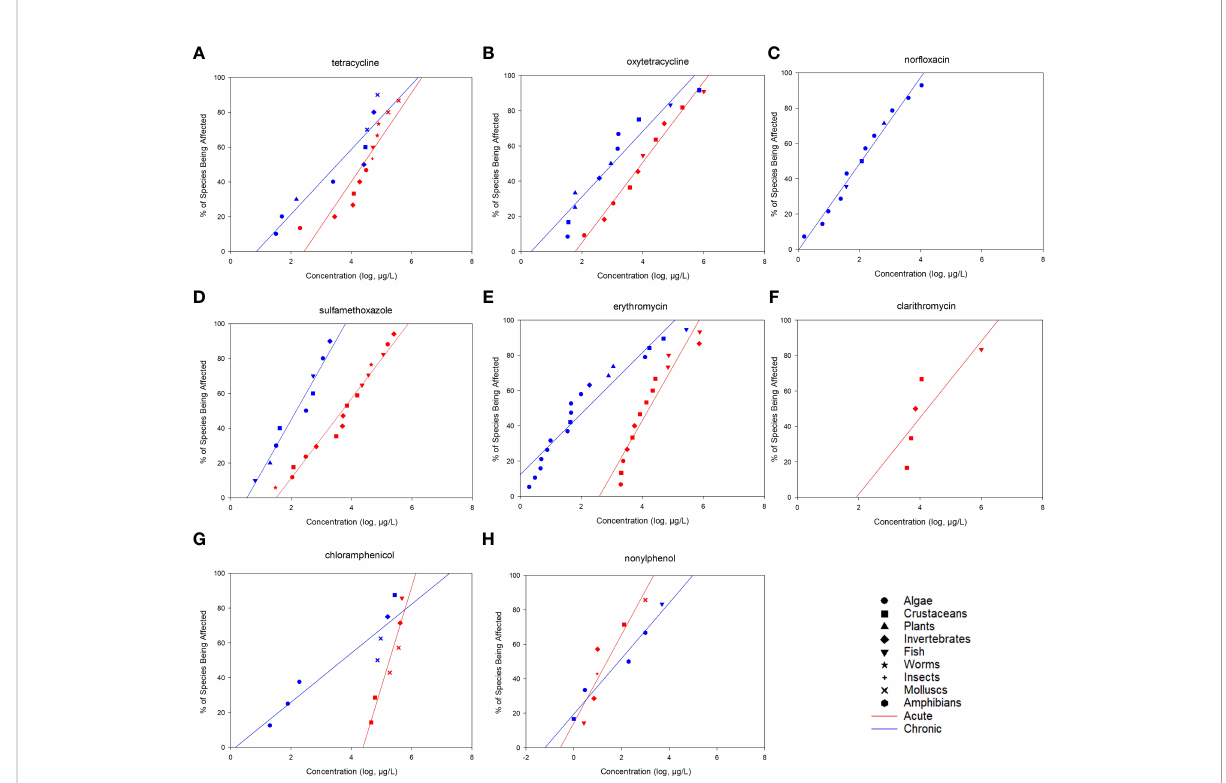
FIGURE 1 Freshwater acute (red) and chronic (blue) species sensitivity distributions (SSDs) for (A) tetracycline, (B) oxytetracycline, (C) nor fl oxacin, (D) sulfamethoxazole, (E) erythromycin, (F) clarithromycin, (G) chloramphenicol, (H)